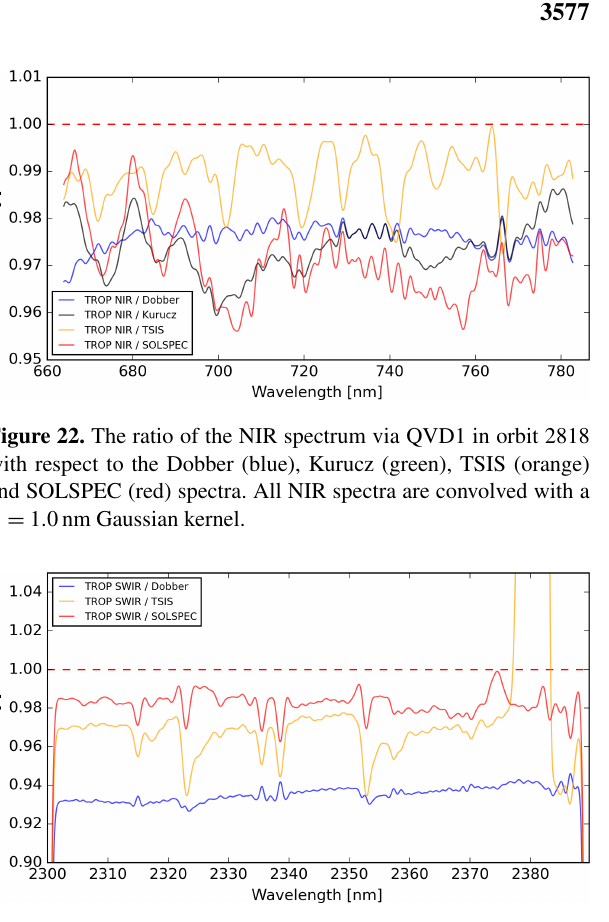
Figure 23. The ratio of the SWIR spectrum via QVD1 in orbit 2818 with respect to the Dobber (blue), TSIS (orange) and SOLSPEC (red) spectra. The TSIS spectrum deviates more than 15% around 2380nm, so it is off the scale. All SWIR spectra are convolved with a σ = 0 . 5nm Gaussian